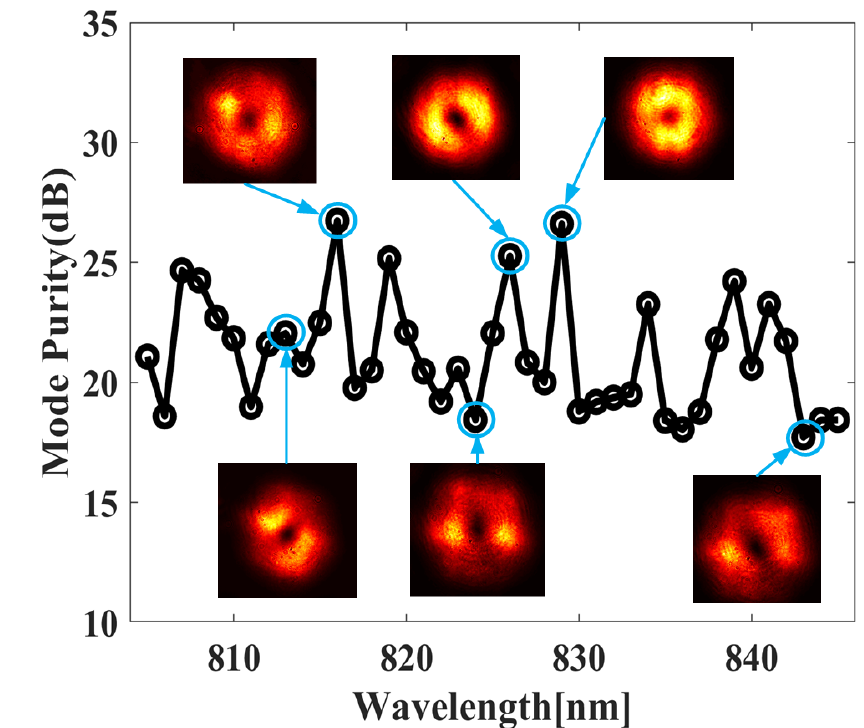
Figure 5. Mode purity of OAM beam at fiber output as a function of wavelength (from 805 to 845 nm in step on 1 nm using tunable laser), Inset: output beam images for selected wavelengths.